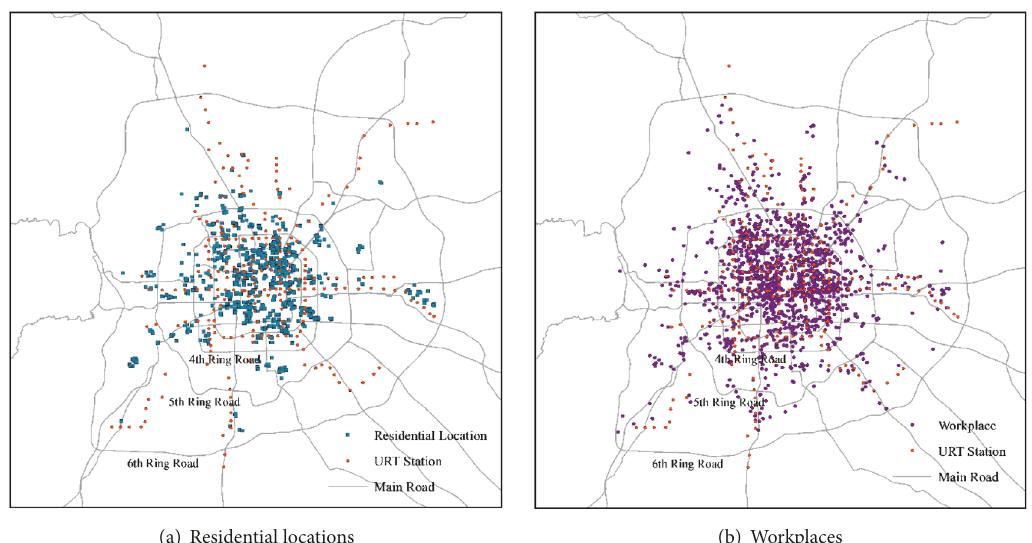
Figure 2: Residential locations and workplaces in this study.